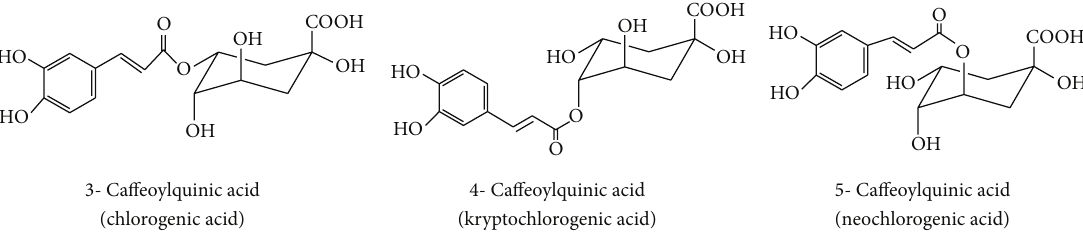
Figure 1: Chemical structures of caffeoylquinic acids studied in the present work [3,